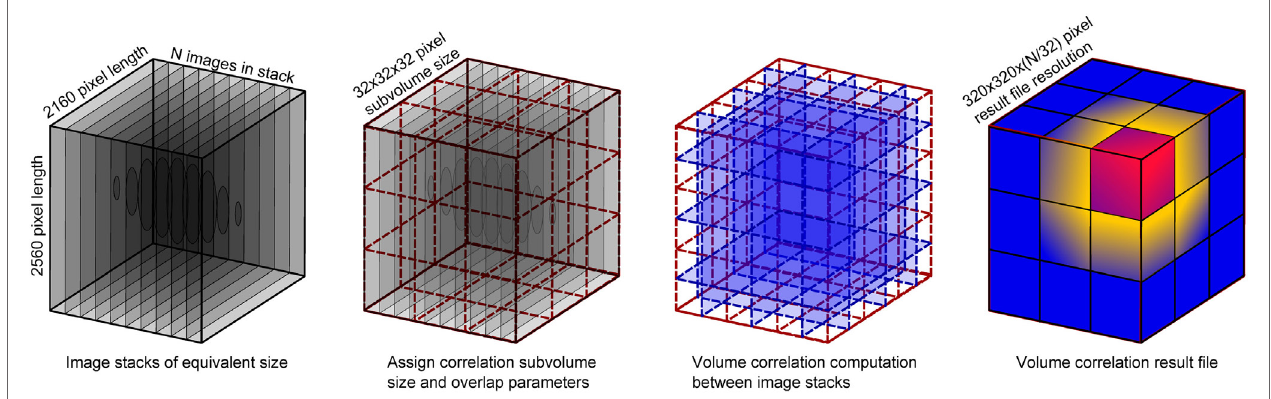
FigUre 2 | Schematic of the volume correlation process, including details of the input volume size versus the result file